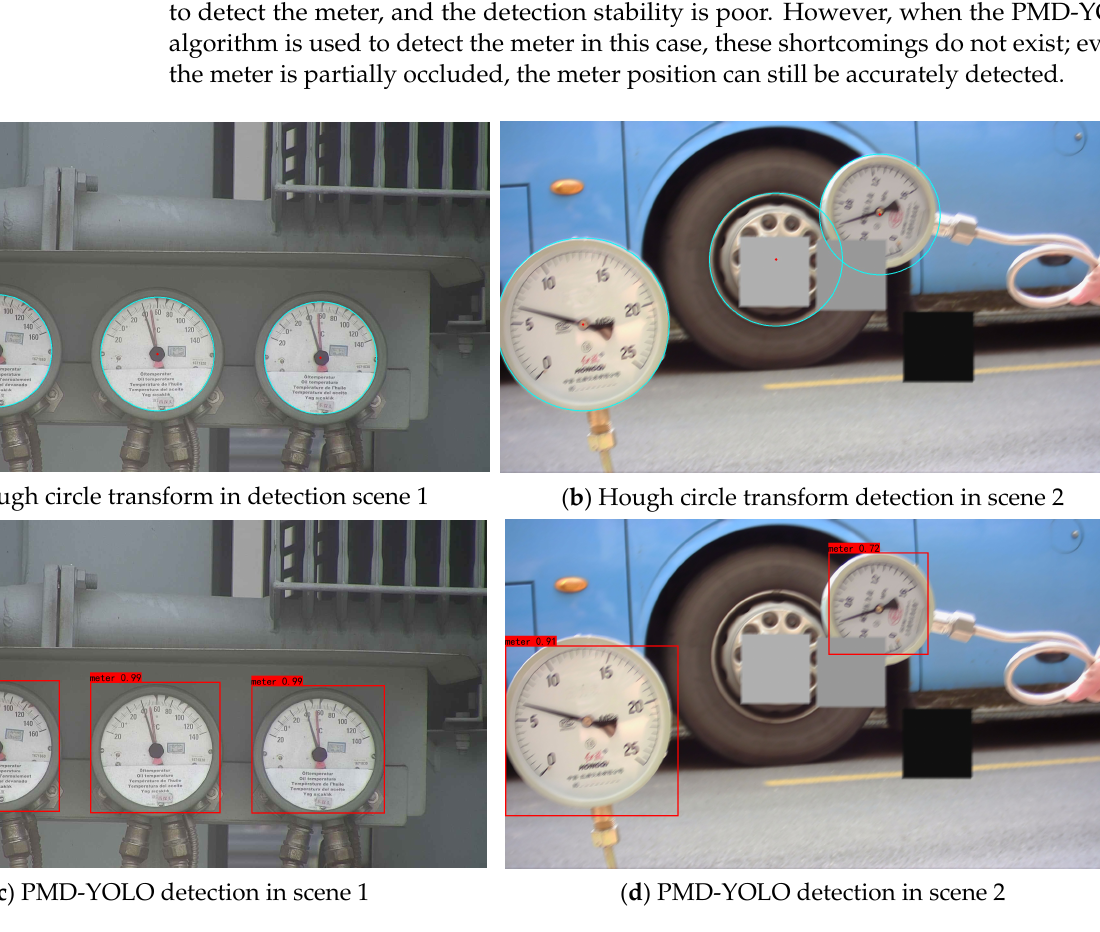
Figure 13. Comparison detection results of Hough circle transform and PMD-YOLO. The object confidence scores in ( c , d ) are shown from left to right: ( c ) shows 0.99, 0.99, and 0.99; ( d ) shows 0.91 and 0.72.